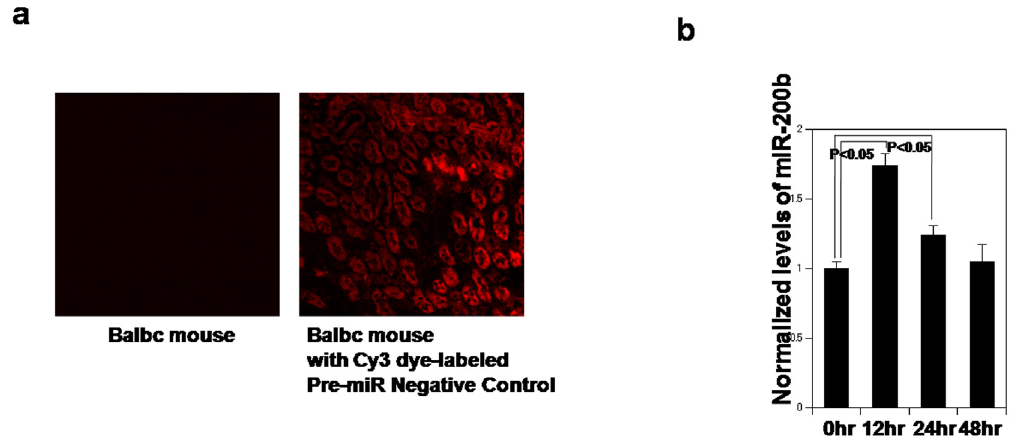
Figure 2. Injected miR-200b precursor can be converted to mature miR-200b in kidneys. a . Laser microscopy images of kidney, frozen sections at 24 hr after intravenously administration of Cy3 dye-labeled Pre-miR control. b . Changes in miR-200 family levels in Balbc mice kidneys 12, 24, 48 hours after intravenously administration of miR-200b precursor, as measured by TaqMan qRT-PCR and normalized to U6 expression. The data are means from experiment measured in triplicate and are presented as mean 6 S.E. P , 0.05: kidneys 12, 24 hours after intravenously administration of miR-200b precursor compared with 0 hour.